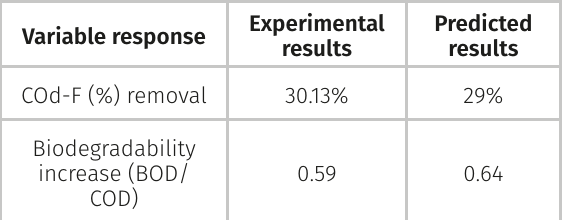
Table IX. Expected results and obtained experimentally for optimal condition established by the statistical